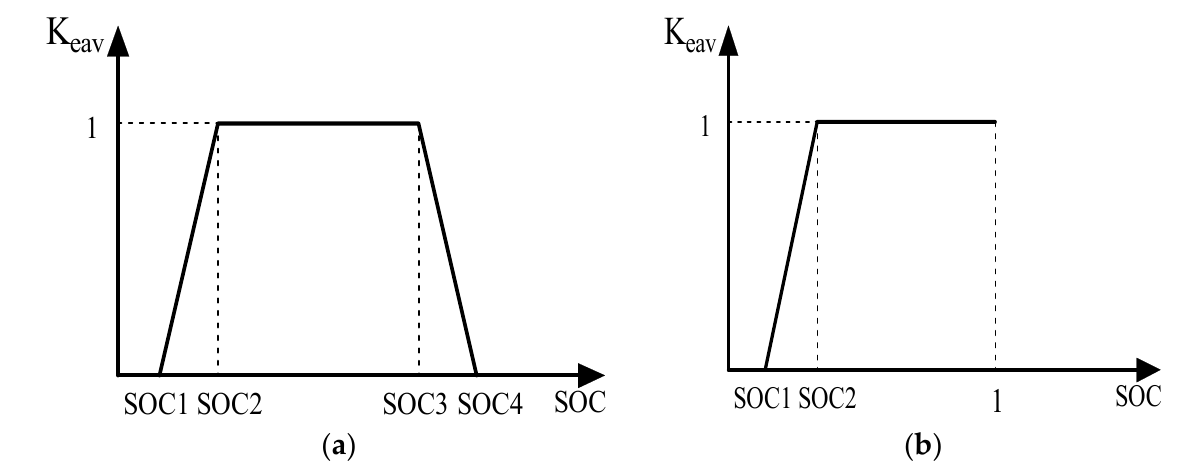
Figure 3. State of charging EV battery [51]: ( a ) EVs’ charging mode; ( b ) EVs in the idle mode.